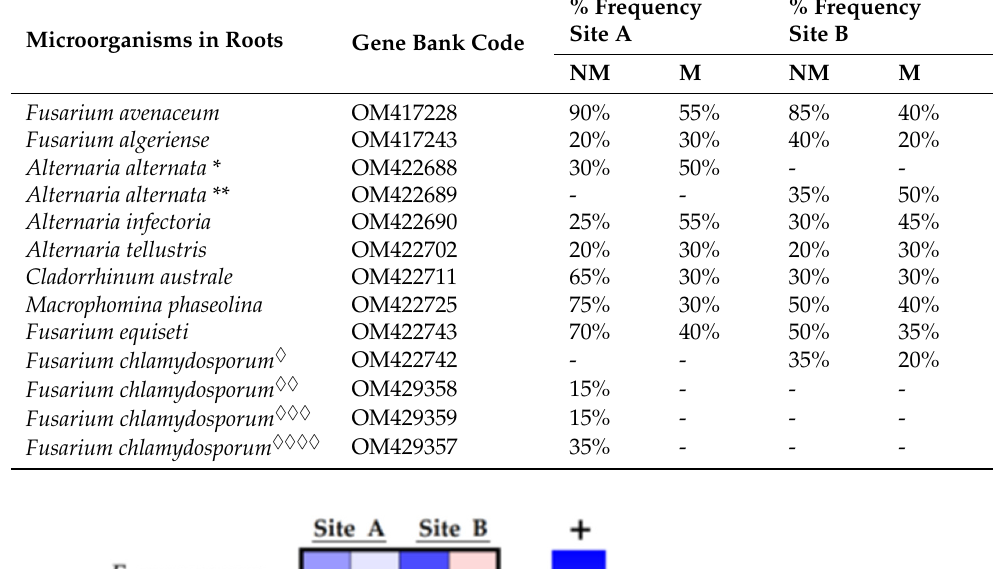
Table 1. and visibly evidentiable by the chromatism of the heat map Figure 4. Table 1. Percentage frequency of endophytic fungi isolated from the roots of 20 Triticum durum plants harvested at sites A and B not treated with mycorrhizae NM and treated with mycorrhizae M. Different strains are indicated by superscript asterisks (“*”, “**”) and diamonds (“ ♦♦♦♦ and “ ”).